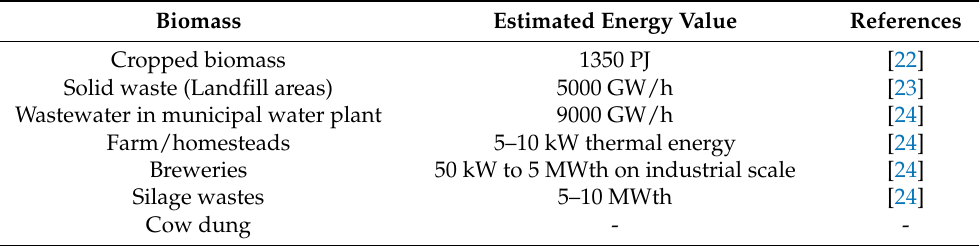
Table 1. Biogas production potential in South Africa in the year 2020 [21].